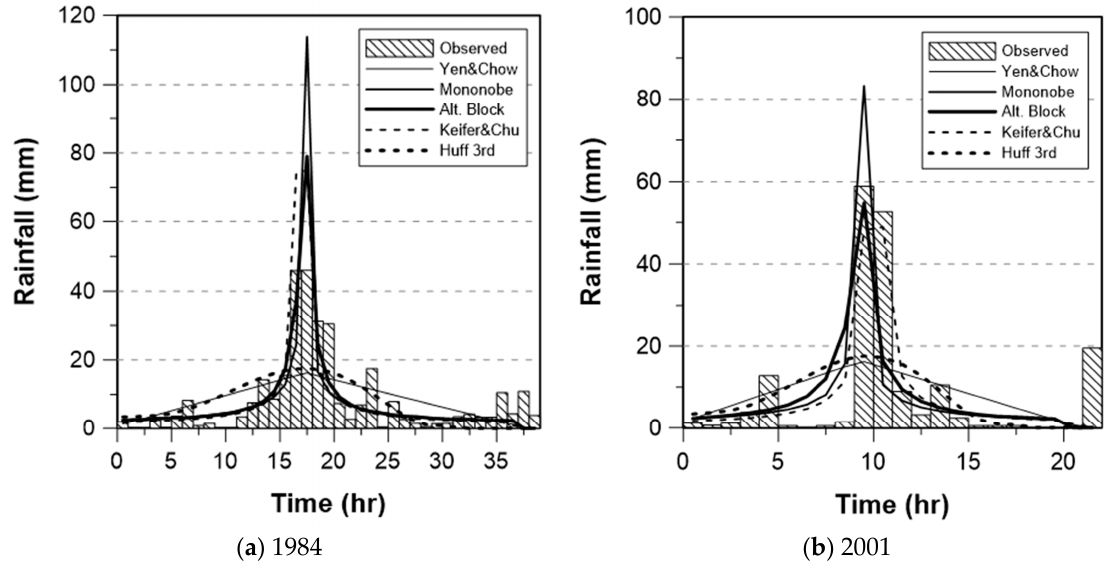
Figure 3. As for Figure 2, but for Case 2.